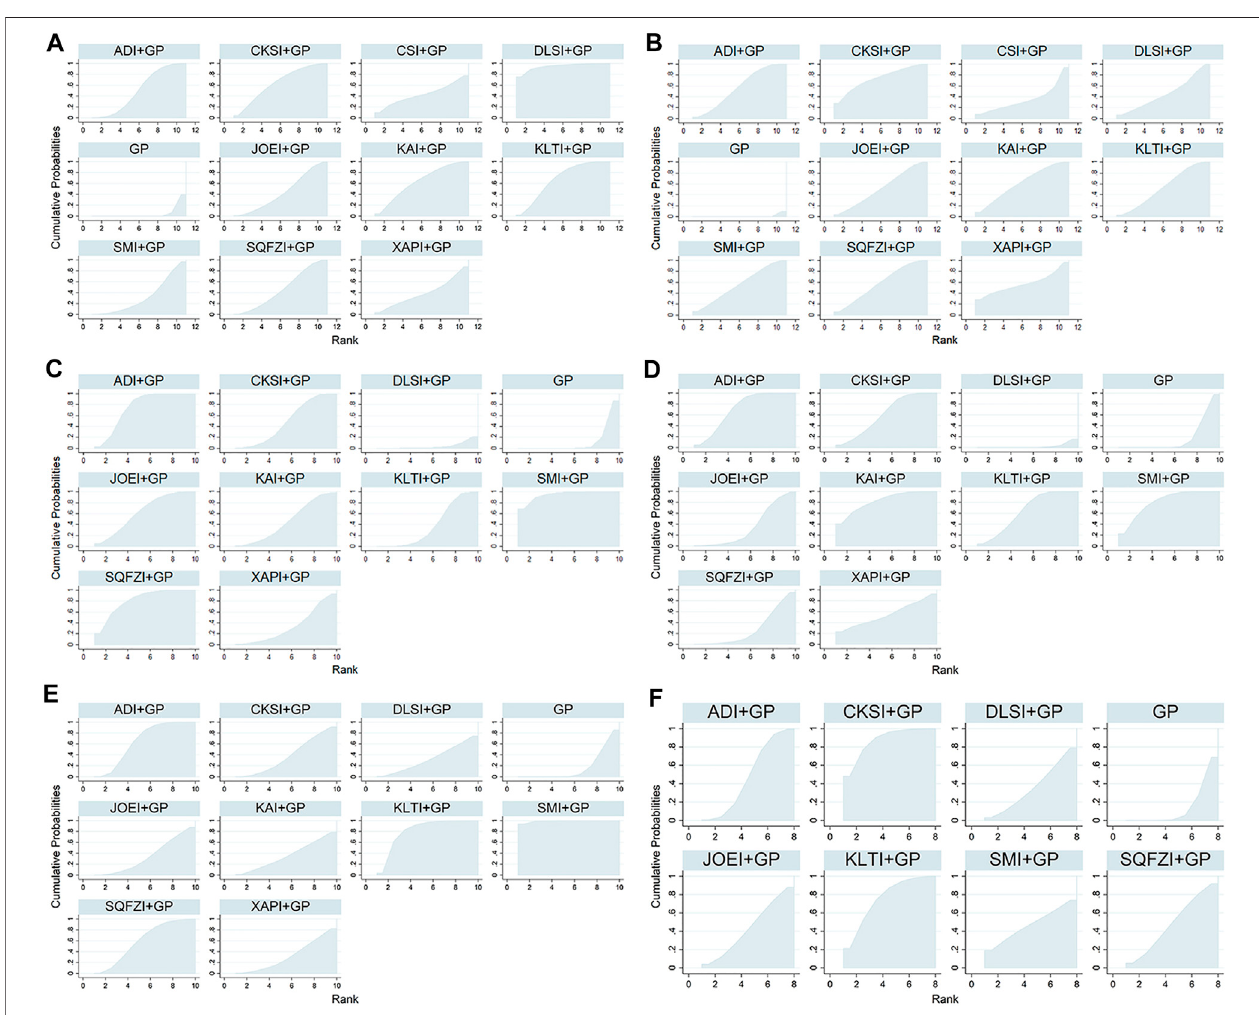
FIGURE5| Surfaceunderthecumulativerankingcurvesforoutcomes. (A) Clinicaleffectivenessrate; (B) Performancestatus; (C) Leukopenia; (D) Gastrointestinal reactions; (E) Thrombocytopenia; and (F) Abnormal liver function. Note: ADI, Aidi injection; CKSI, Compound Kushen injection; DLSI, Delisheng injection; GP, GemcitabineplusCisplatin;JOEI,Javanicaoilemulsioninjection;KAI,Kangaiinjection;KLTI,Kanglaiteinjection;SMI,Shenmaiinjection;SQFZI,Shenqifuzhenginjection; and XAPI, Xiaoaiping injection.